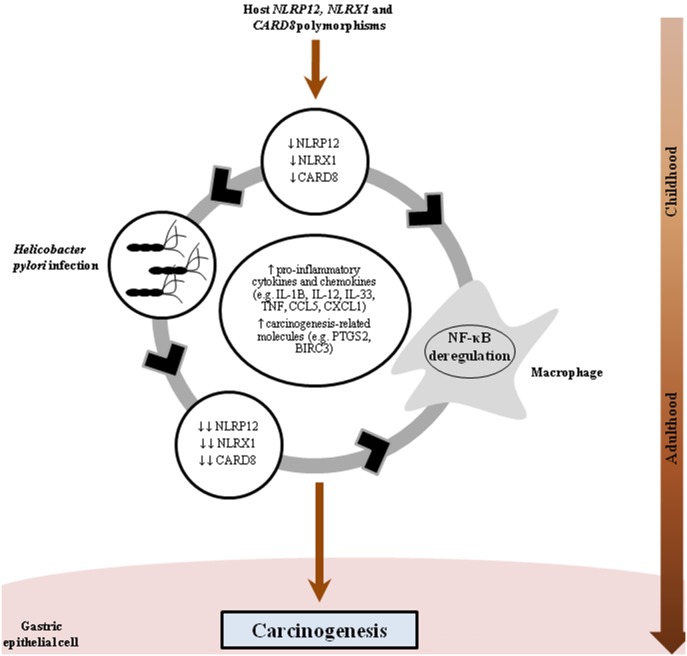
Polymorphisms in the NOD-like receptor signalling pathway increase the risk of Helicobacter pylori-related gastric cancer.Individuals harbouring NLRP12, NLRX1 and CARD8 polymorphisms would have decreased levels or defective NLRP12, NLRX1 and CARD8, and thus, would be more susceptible to acquisition of H. pylori in childhood and present deregulation of NF-κB. Once established, H. pylori infection appears to intensify the decreased expression of these NF-κB-negative regulators. These factors would lead to the production of pro-inflammatory cytokines (IFNB1, IL1, IL-12B, IL6, IL33 and TNF), chemokines (CXCL1, CXCL2, CCL5) and carcinogenesis-related molecules (PTGS2 and BIRC3), among others, which would facilitate the sequence of events that characterises GC development including inflammation, atrophy, intestinal metaplasia, dysplasia, carcinoma in situ, and finally invasive gastric cancer.